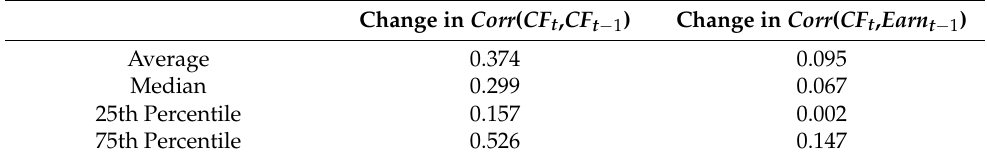
Table 2. Effects of seasonality